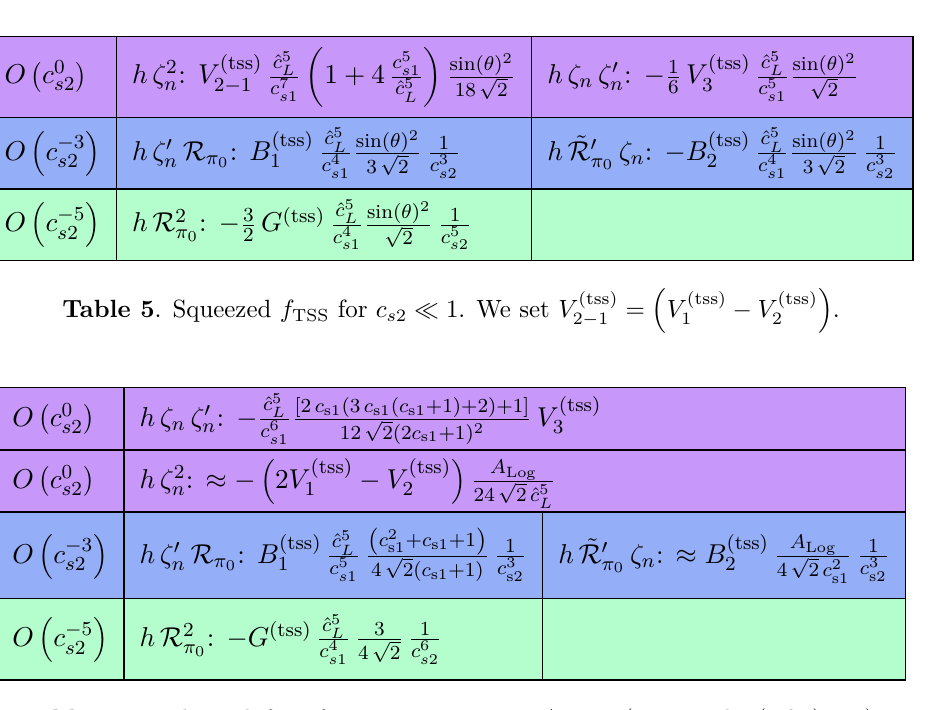
Table 6 . Equilateral f TSS for c s 2 (cid:28) 1 . We set A Log = (3 γ e + 3 log( − k t ) − 4)